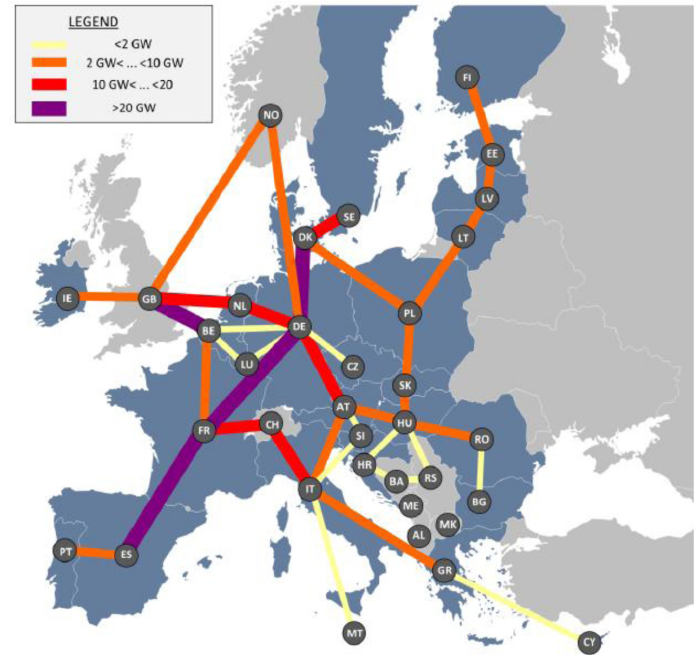
Figure 7. Hydrogen infrastructure in the reference scenario.